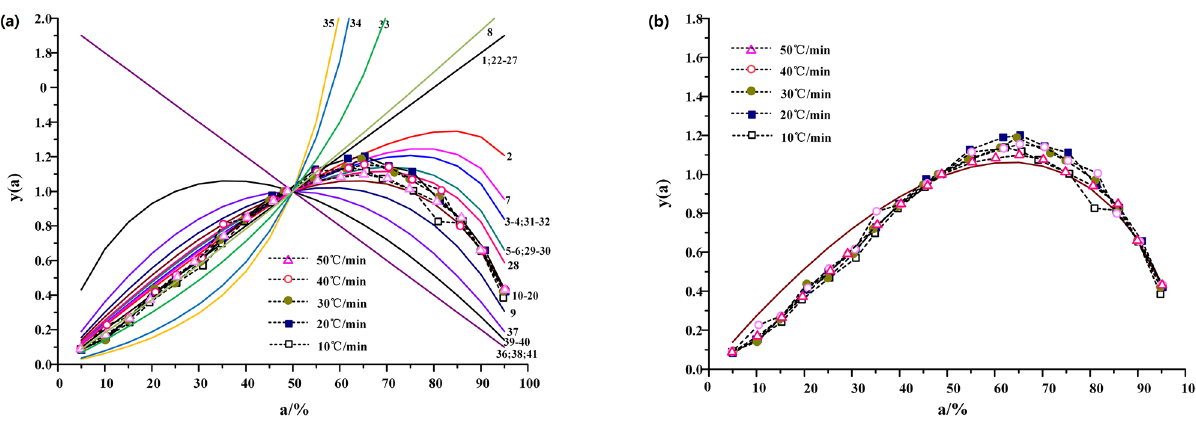
Figure 3. Standard and experimental curves of y(α)-α under CO 2